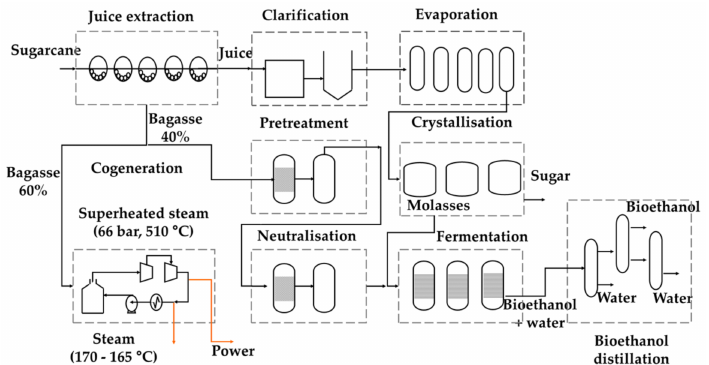
Figure 1. Production of 1G and 2G bioethanol from sugarcane.